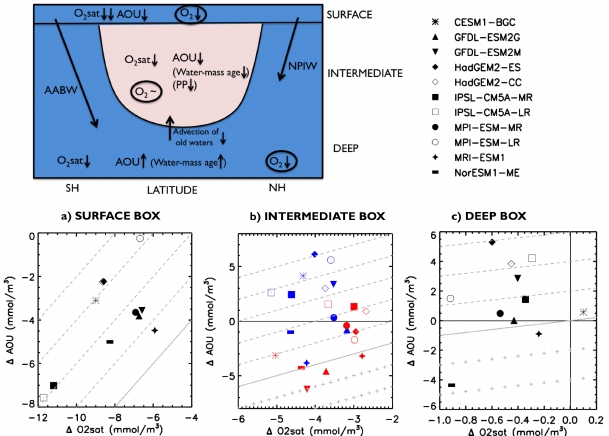
Figure 10. Top: schematic of the 100-year change (1960–1999 to 2060–2099) in O 2 across CMIP5 models. Bottom: relation- ship between the 100-year change in apparent oxygen utilization ( (cid:49) AOU, mmolm − 3 ) and the analogous change in O 2 sat ( (cid:49) O 2 sat, mmolm − 3 ) estimated by individual CMIP5 models in the Pacific Ocean in (a) the surface layer (average from 50m to 200m), (b) the intermediate layer (average from 200 to 1000m) and (c) the deep layer (average from 2000 to 4000m). Solid grey lines in panels indi- cate no change in oxygen, dashed lines indicate decrease in oxygen concentration (–), and plus lines indicate increase in oxygen ( + ) . In the intermediate box, low-latitude values are represented in red (coinciding with decrease in multi-model mean age of at least 20 years) and high latitudes, i.e. zones of water formation (where age increases), are shown in